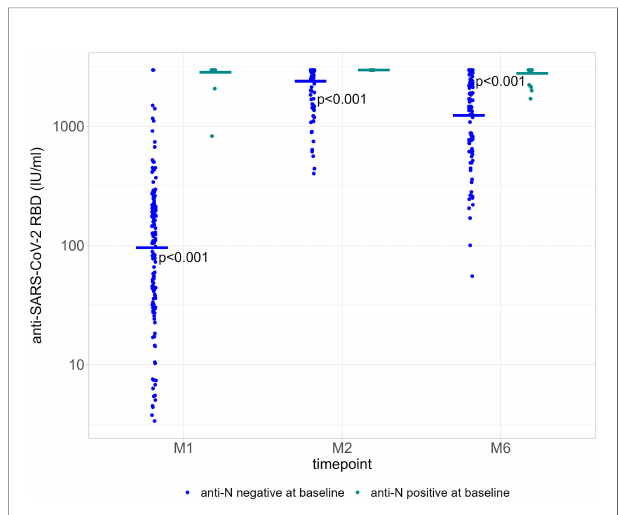
FIGURE 2 | Quanti fi cation of anti-RBD Ig (GMT) according to baseline anti-N positivity (negative, blue dots; positive, green dots) at each time point. P value signi fi cant if <0.05. RBD, receptor binding domain; GMT, geometric mean titers; M1, 30 days after the fi rst vaccine dose; M2, 60 days after the fi rst vaccine dose; M6, 6 months after the fi rst vaccine